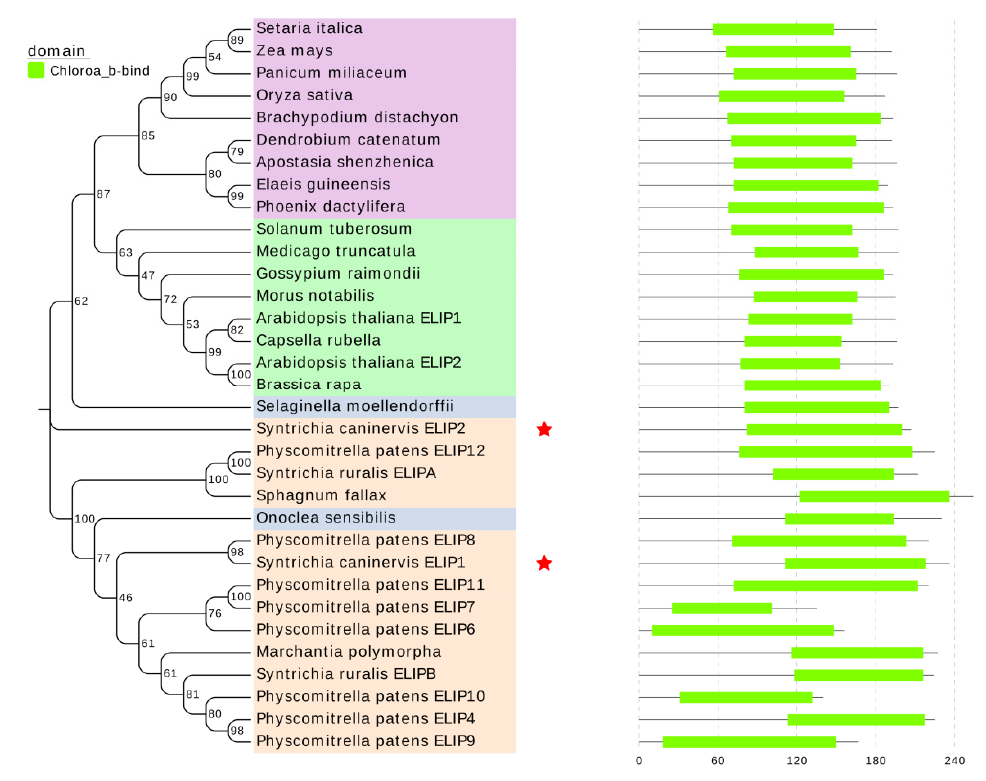
Figure 1. The phylogenetic tree inferred from the deduced protein sequence of ScELIPs and other 34 ELIP amid acid sequences represented by 24 additional taxa and conserved domain. In the left pannel, numbers above the lines represent bootstrap percentages (based on 1000 replicates). A bootstrap value of 100% indicates branches that were supported in all replicates of resampling of data. The scale bar indicates the number changes per unit length. The two ScELIPs were highlighted by a red star. Different colors represent different evolving groups, pink (bryophytes), blue (ferns), purple (monocots), and green (eudicots). In the right pannel, the conserved domain of ELIPs corresponding to the left pannel.